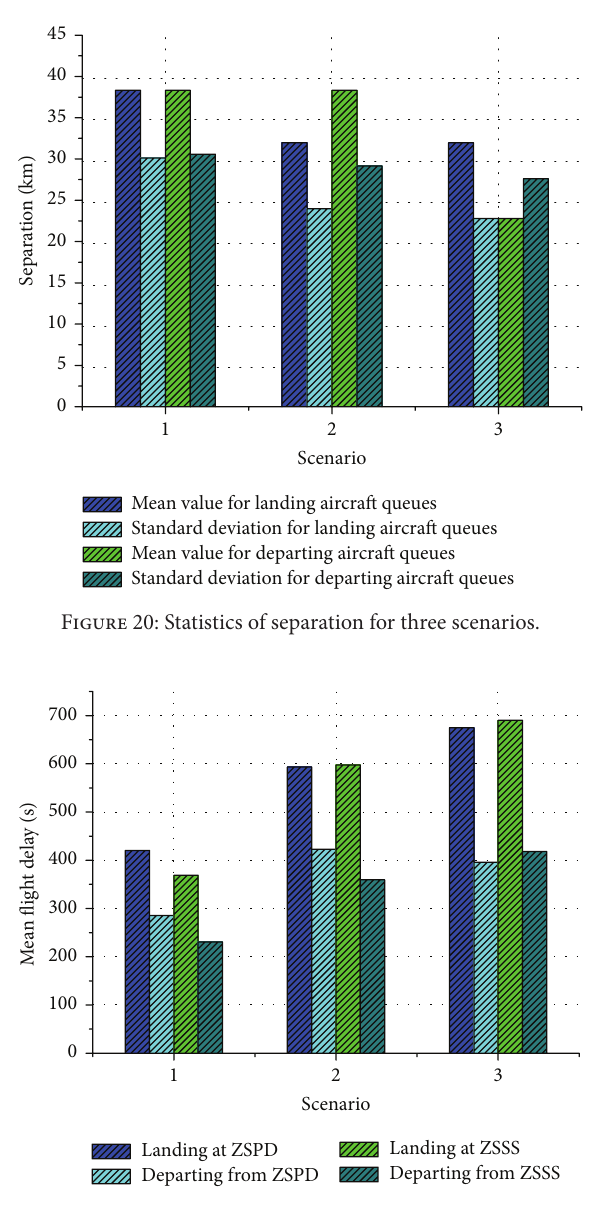
conflict with each other and 𝑛 2 𝑃 represents the complexity of probing two sampling points from each potential